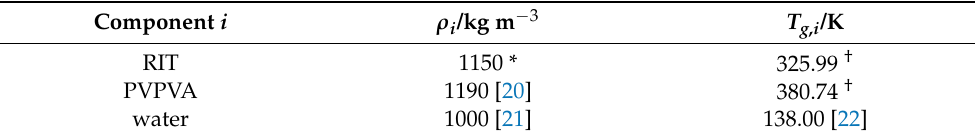
Table 2. Pure component densities and glass transition temperatures of RIT, PVPVA, and water. Component i ρ i /kg m − 3 T g , i /K RIT 1150 * 325.99 † PVPVA 1190 [20] 380.74 † water 1000 [21] 138.00 [22]